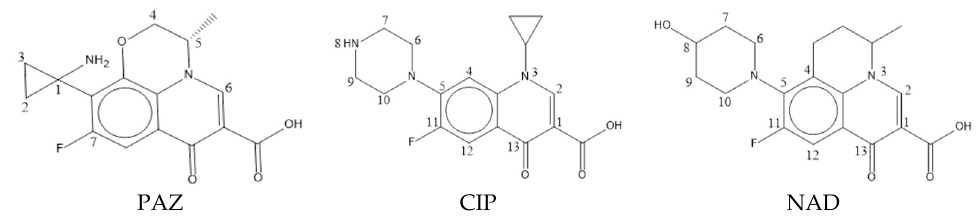
Figure 1. Molecular structure of pazufloxacin (PAZ), ciprofloxacin (CIP), and nadifloxacin (NAD).